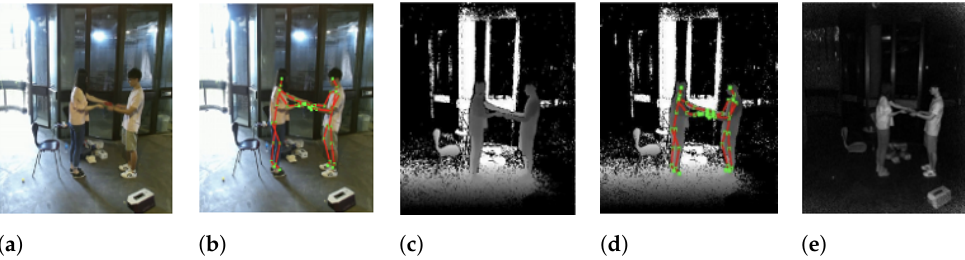
Figure 2. Example data captured by an RGB-D sensor as taken from the NTU RGB-D dataset [31] in ( a ) RGB, ( b ) RGB + Skeleton Joints, ( c ) Depth, ( d ) Depth + Skeleton Joints, and ( e ) IR modalities.